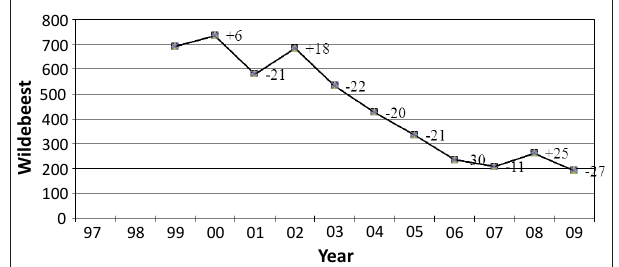
FIGURE 6: Decline in the blue wildebeest population in a private protected area between 1997 and 2009 (figures indicate percentage decline per